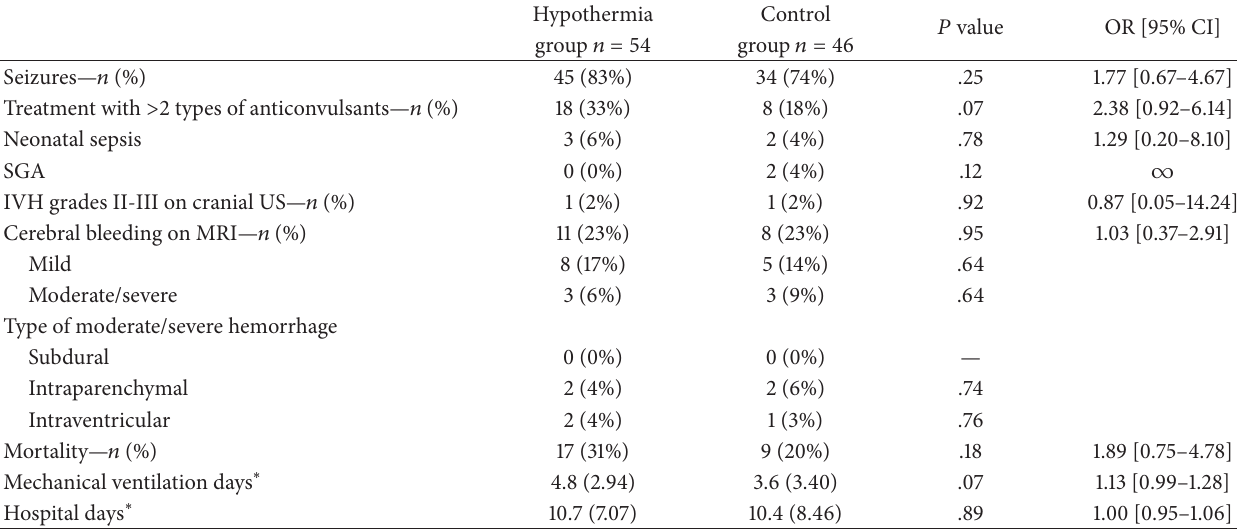
Table 3: Morbidity, clinical findings, and presence of hemorrhage on